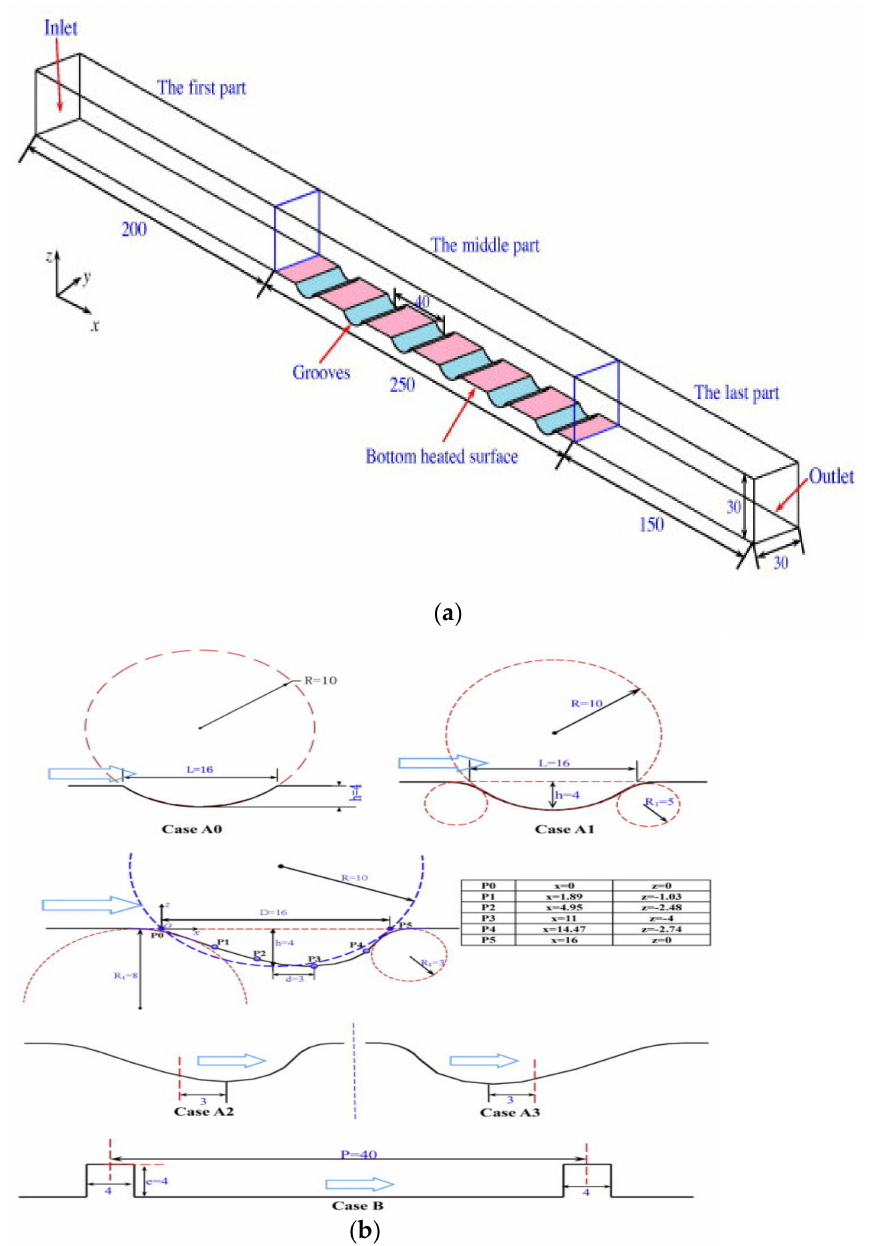
Figure 7. Rectangular micro-channel [83] © Elsevier, 2015; ( a ) geometry description; ( b ) various cylindrical grooves (cases A0–A3) and square ribs (case B). Zhai et al. [85] simulated the flow in micro-channels with six types of cavities and ribs in the single micro-channel walls. These were “triangular-cavities with circular-rib (a) (Tri.C-C.R for short), (b) triangular-cavities with triangular-rib (Tri.C–Tri.R for short), (c) triangular-cavities with trapezoidal-ribs (Tri.C–Tra.R for short), (d) trapezoidal-cavities with circular-rib (Tra.C-C.R for short), (e) trapezoidal-cavities with circular-rib (Tra.C-C.R for short), (f) trapezoidal-cavities with trapezoid-rib (Tra.C-Tra.R for short)”, as seen in Figure 8. De-ionized water was used as a coolant with a Reynolds number ranging from 300 to 600, and a constant heat flux of 10 6 W/m 2 was applied at the bottom wall of the micro- channel. The finite volume method and FLUENT software was adopted to investigate